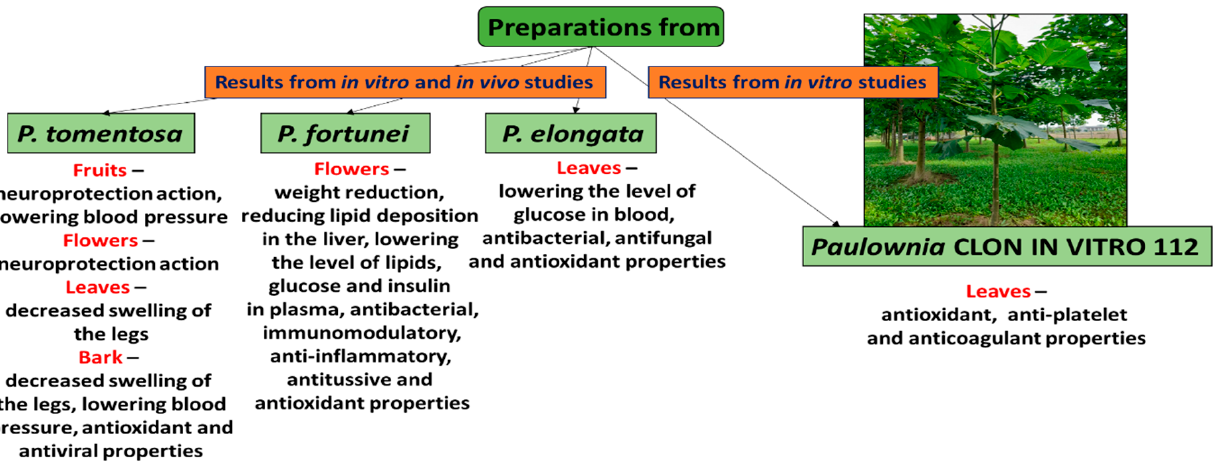
Figure 1. Biological activity of preparations from organs of various species of Paulownia .